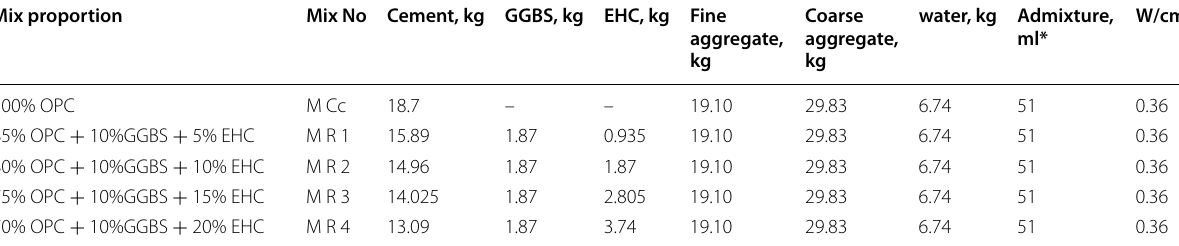
*Admixture used as ASTM C-494/C 494M recommendation a superplasticizer as 3 ml per one kilogram by weight of cementitious material Mix Cc control high-strength concrete mix, M R 1, 2, 3, and 4 are 15%, 20%, 25%, 30%, respectively, of EHC blended with constant 10% GGBS concrete mix made partial = replacement of cement